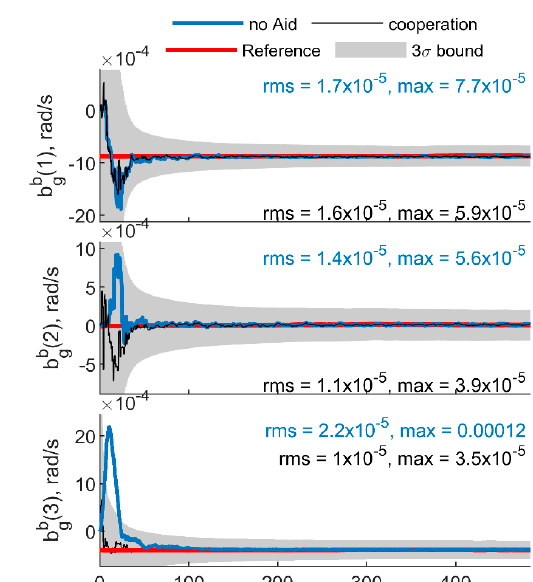
Figure 17. ( a ) Accelerometer and ( b ) gyroscope biases predicted by the filter. One deputy. Chief and deputy formation identified by case 2. Reference value is reported in red. Results obtained with cooperation and without cooperation have been reported in black and blue, respectively. RMS and maximum error value have been evaluated starting from t = 60 s.